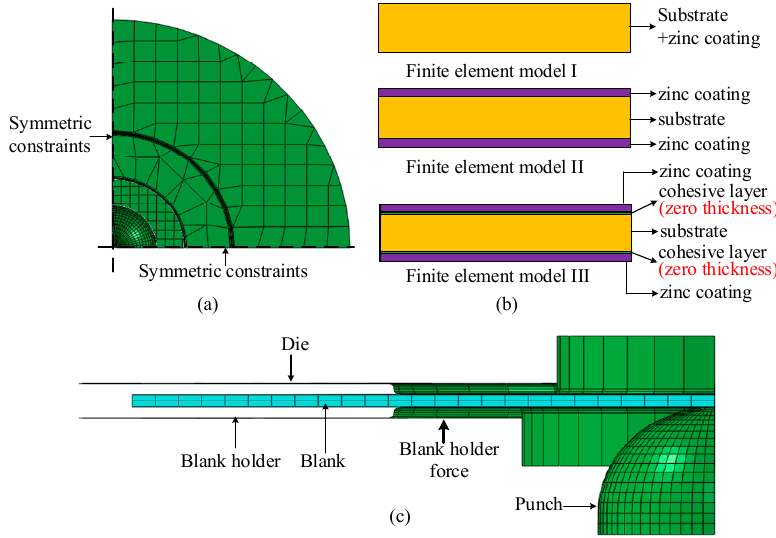
Figure 13. Preprocessing model of finite element analysis: ( a ) 1/4 symmetry constraints of sheet material, ( b ) Assumption of finite element model for layered structure of galvanized steel sheet, ( c ) Finite element assembly models.